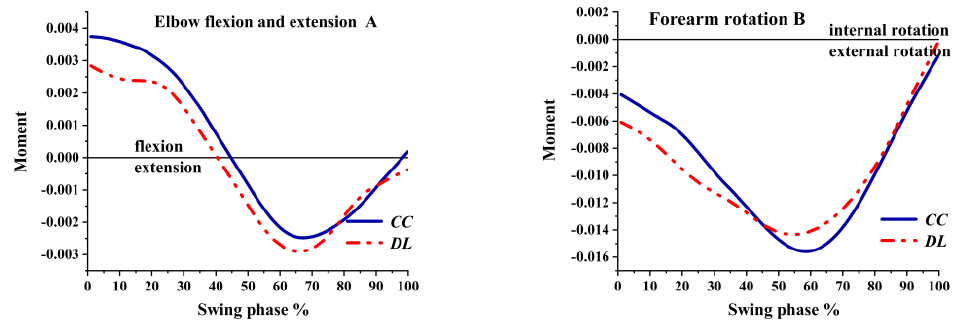
Figure 12. The moment of elbow joint during swing phase. The shoulder moment varied from flexion to extension in the sagittal plane and varied from the abduction to adduction moment in the coronal plane. The shoulder was always external rotation in the transverse plane during the whole swing phase, as shown in Figure 13C. The maximum external moment was greater in CC than DL. The external rotation moment decreased both in DL and CC before the impact, but it was still the external moment.